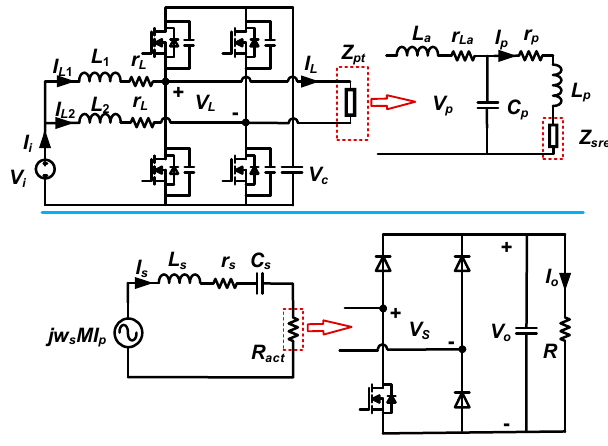
Figure 7. Equivalent circuit diagram.